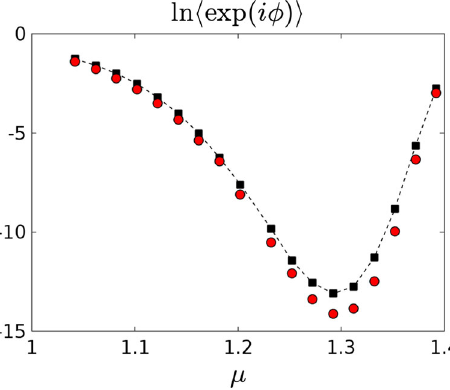
Fig. 4 The phase factor expectation value in Gaussian approximation ( red symbols ) in comparison with the exact result ( black ) from [16]